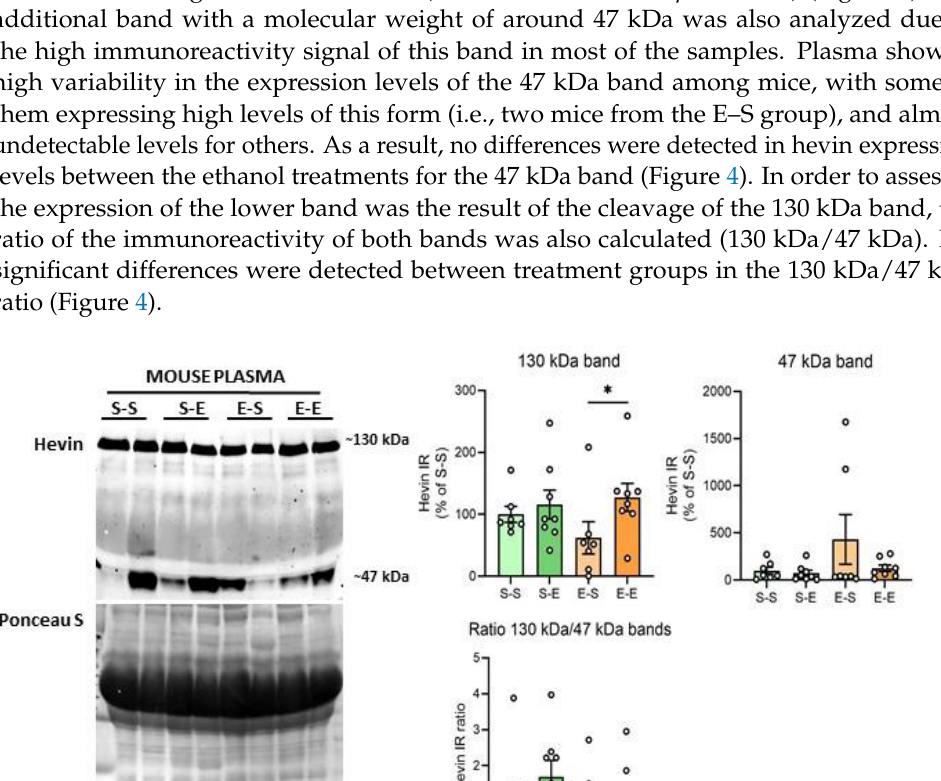
Figure 3. Hevin protein expression in the brain of mice exposed to different regimens of etha- blot images and the graphics representing the actin-normalized immunoreactivity (IR) of the ~130 kDa